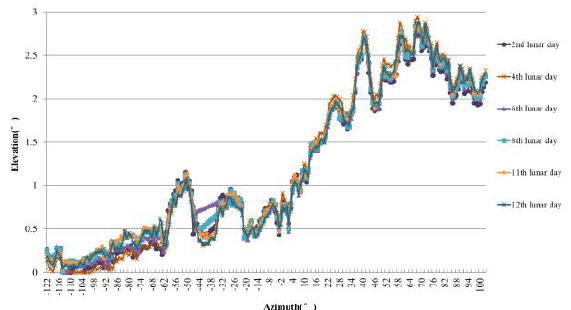
Figure 11. Results of the skyline altitude angles in the first 12 lunar days (Azimuth 0° represents